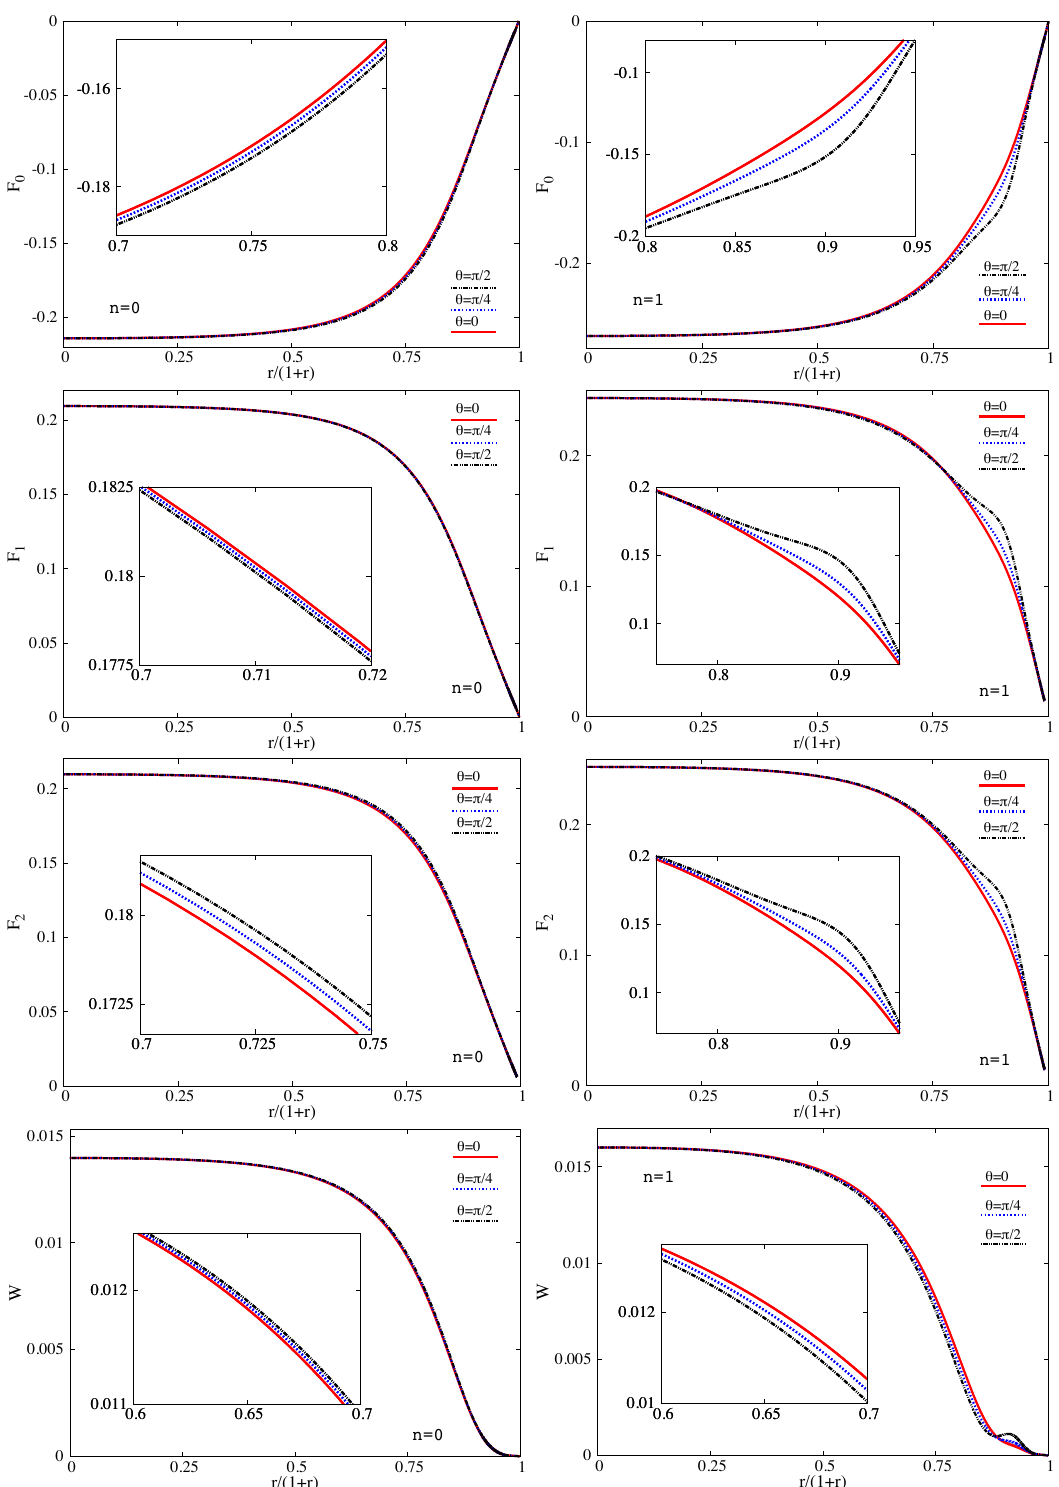
Figure 6 . Metric functions of two Proca stars: n = 0 (left panels) and n = 1 (right